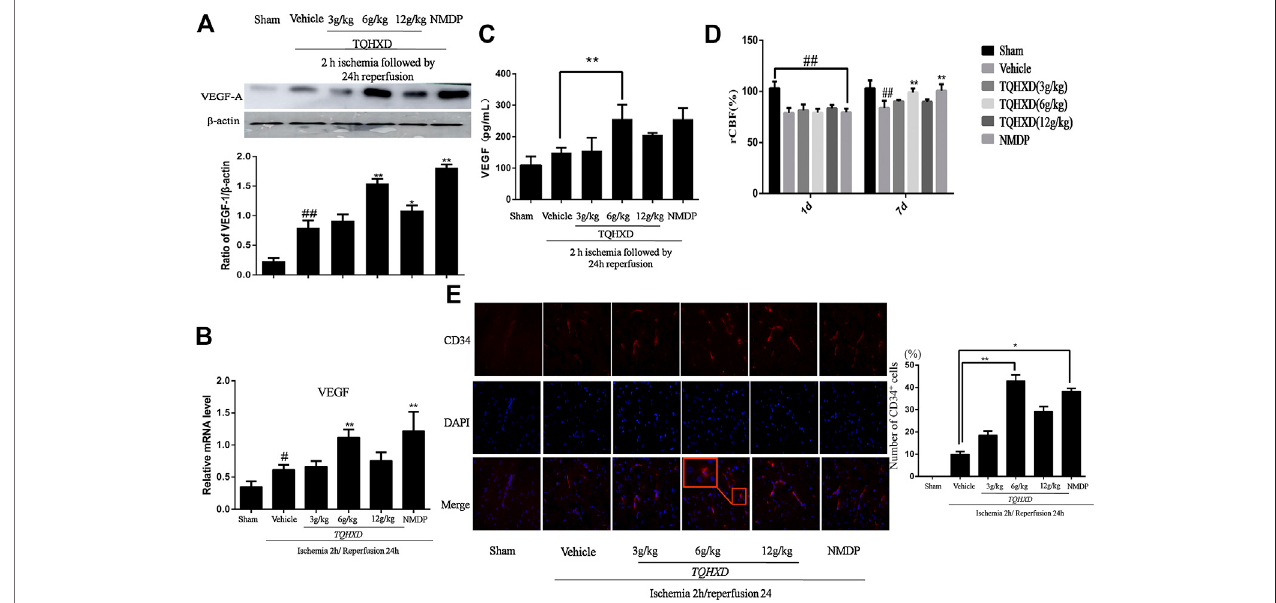
FIGURE 6 | TQHXD strengthened angiogenesis in MCAO rats. (A) Representative band image (top) and quantitative analysis (bottom) of VEGF-A ( n (cid:1) 3). (B) The mRNAexpressionofVEGFincortexdetectedbyqPCR. (C) QuantitativeanalysisforELISAresultsofVEGFat7 days. (D) ThechangesofrCBFforallgroupsat1and7 d after reperfusion, n (cid:1) 3. (E) Immuno fl uorescence of brain section. Angiogenesis was visualized by CD34 staining (red), and DNA was stained by 4 ′ 6,-diamidino-2- phenylindole (DAPI; blue). Red box implies zoom-in fl uorescence. Right, the histograms indicate the percentages of CD34-expressing cells that were positive for indicated markers. Scale bar (cid:1) 50 μ m ( × 200 magni fi cation). Data are presented as means ± SD. ## p < 0.01 vs. sham group; * p < 0.05, ** p < 0.01 vs. vehicle group.